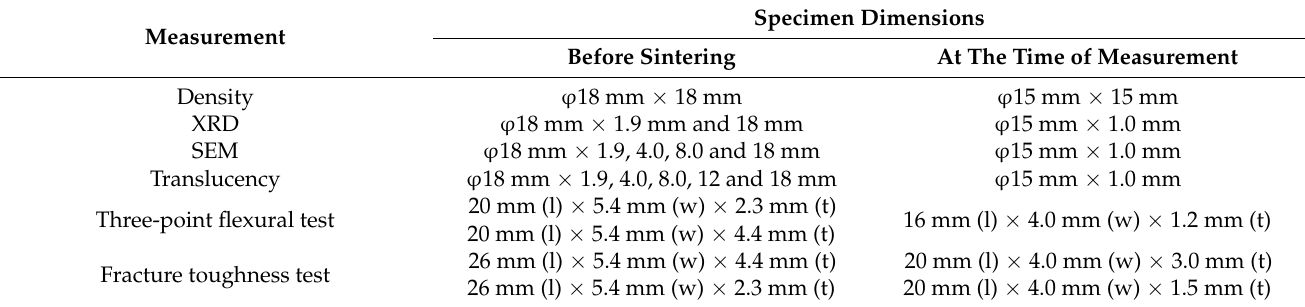
Table 2. Specimen dimensions in each test (the mark “ ϕ ” denotes “diameter”).